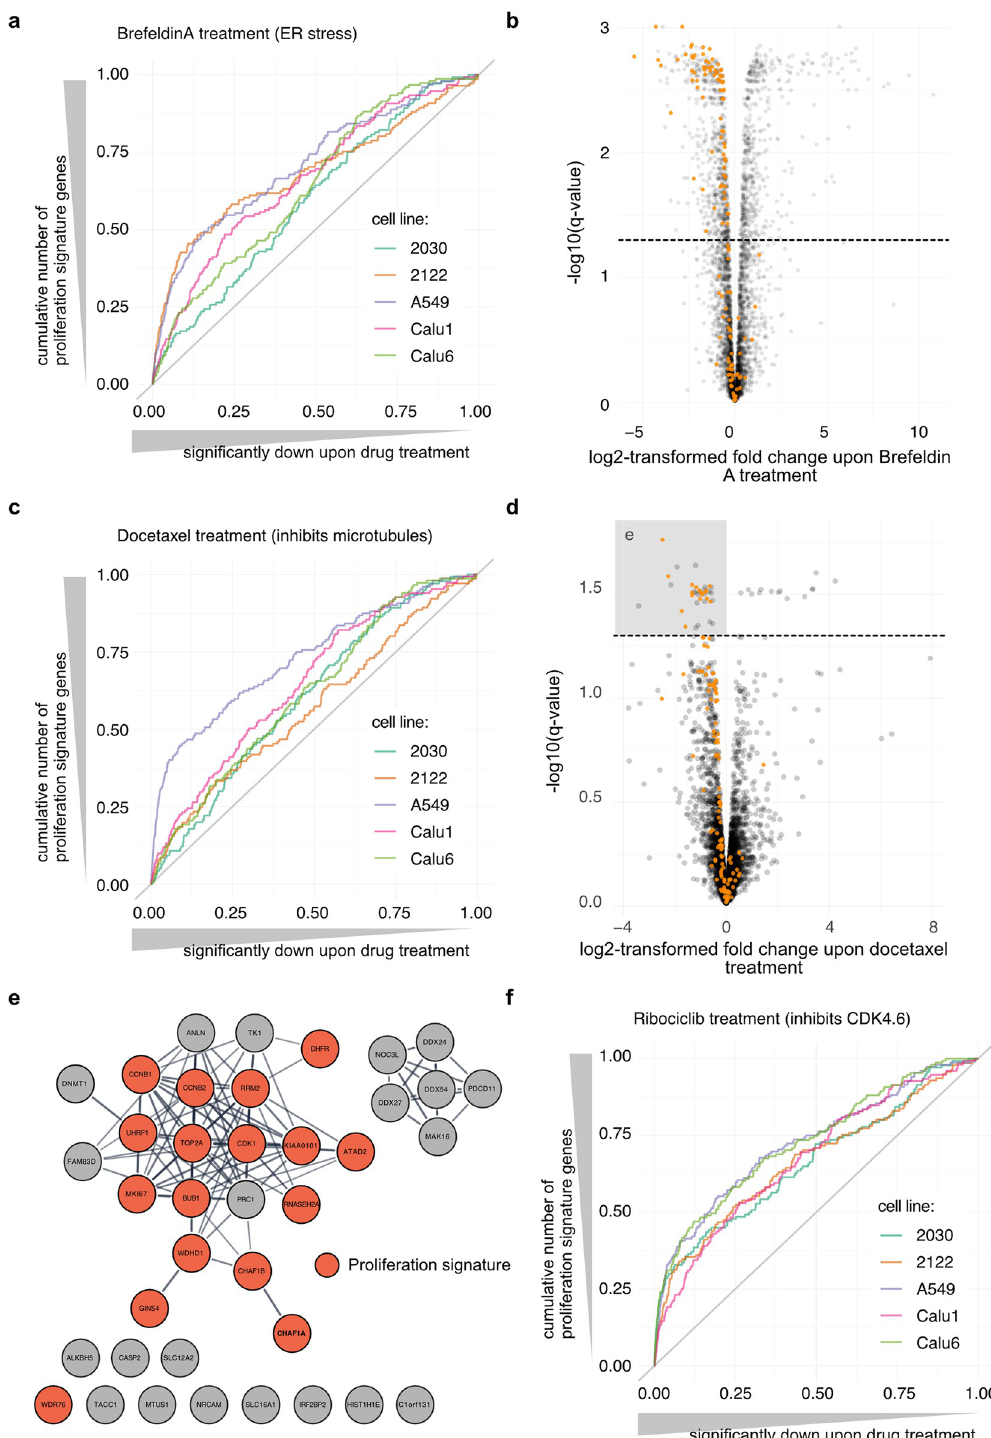
Fig 4. Proliferation signature in the context of drug treatment. a) Enrichment of the proliferation signature in the proteomes of cells treated with Brefeldin A. Proteins were ranked by significance of down-regulation according to Ruprecht et al . [7] ( q -value) (horizontal axis) and the vertical axis presents the cumulative number of signature genes for each cell line. “2030” and “2122” correspond to the NCIH-2030 and NCIH-2122 cell lines, respectively. b) Volcano plot for A549 cells treated with Brefeldin A. Proliferation signature genes are highlighted in orange. The dashed line corresponds to a q -value